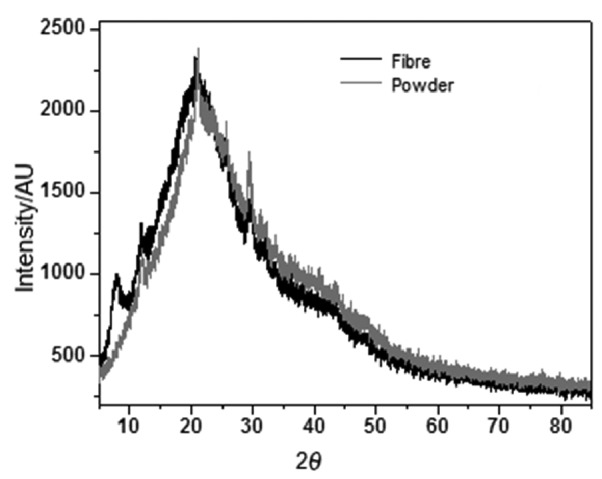
X-ray diffraction (XRD) patterns for collagen powder (grey line) and fibre (black line)